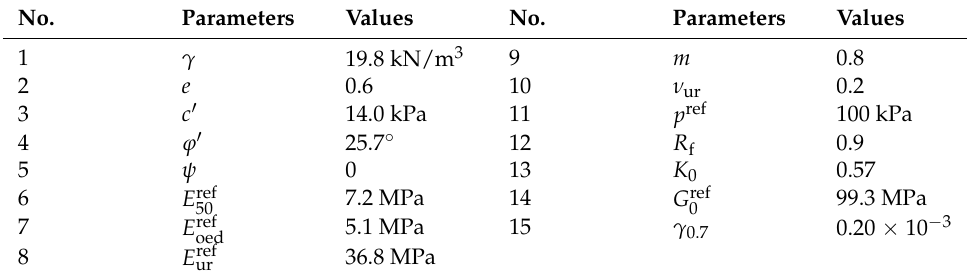
Table 1. Physical and mechanical parameters of HSS model for the soil